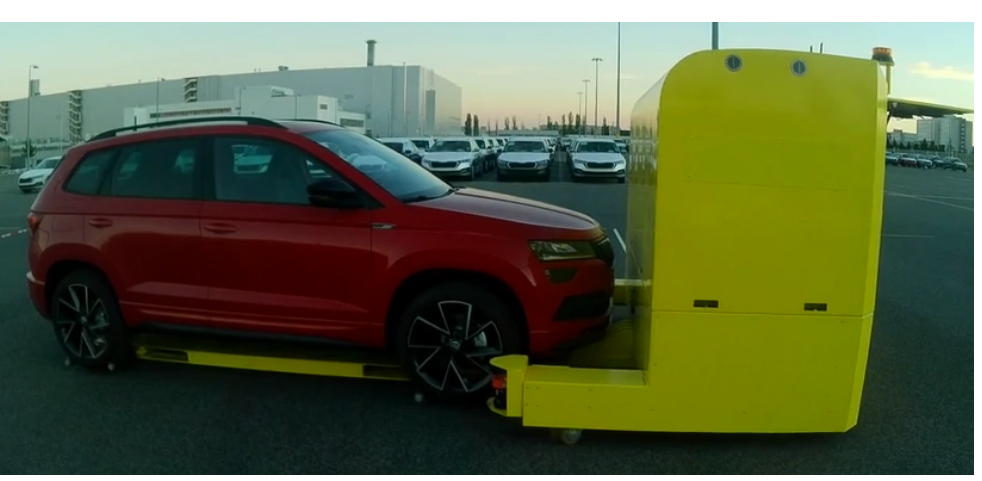
Figure 10. Autonomous vehicle prototype intended for car and heavy load transportation used for the vision-in-the-loop experiments. Courtesy of